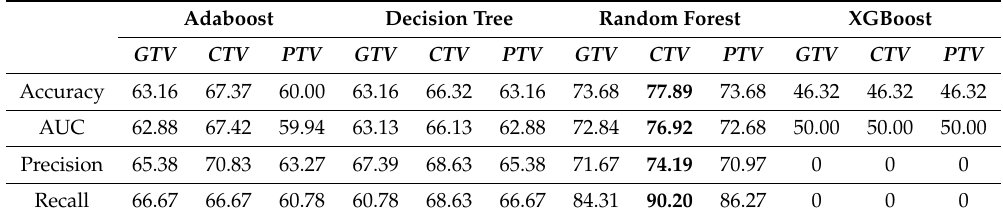
Table 6. Performance with the signature presented by Aerts et al. [19] combined with the classification algorithms used here. The largest performance is highlighted in